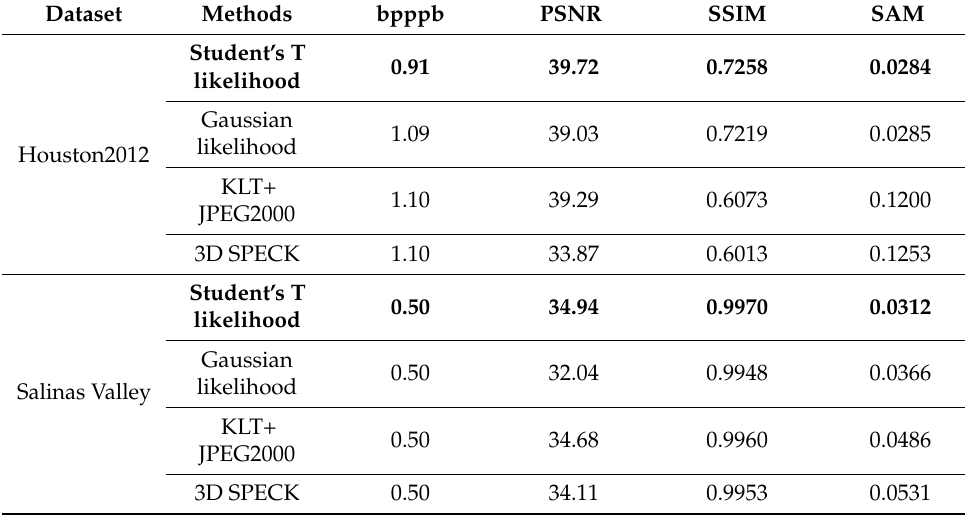
Table A4. Rate-distortion performance for relatively high bit rates; the comparatively ideal choice is marked in bold ( λ = 0.00005